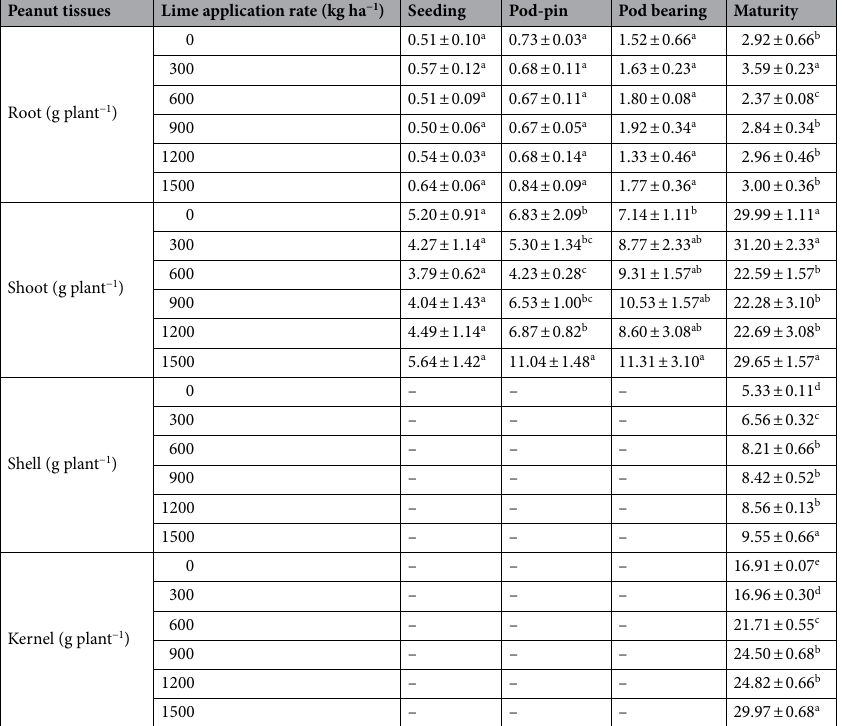
Table 2. Effects of slaked lime applications on peanut tissue biomass in the different growth stages. Values are means (± SD) of three replicates. Different lowercase letters indicate a significant difference ( p < 0.05) among six treatments of slaked lime within the same growth